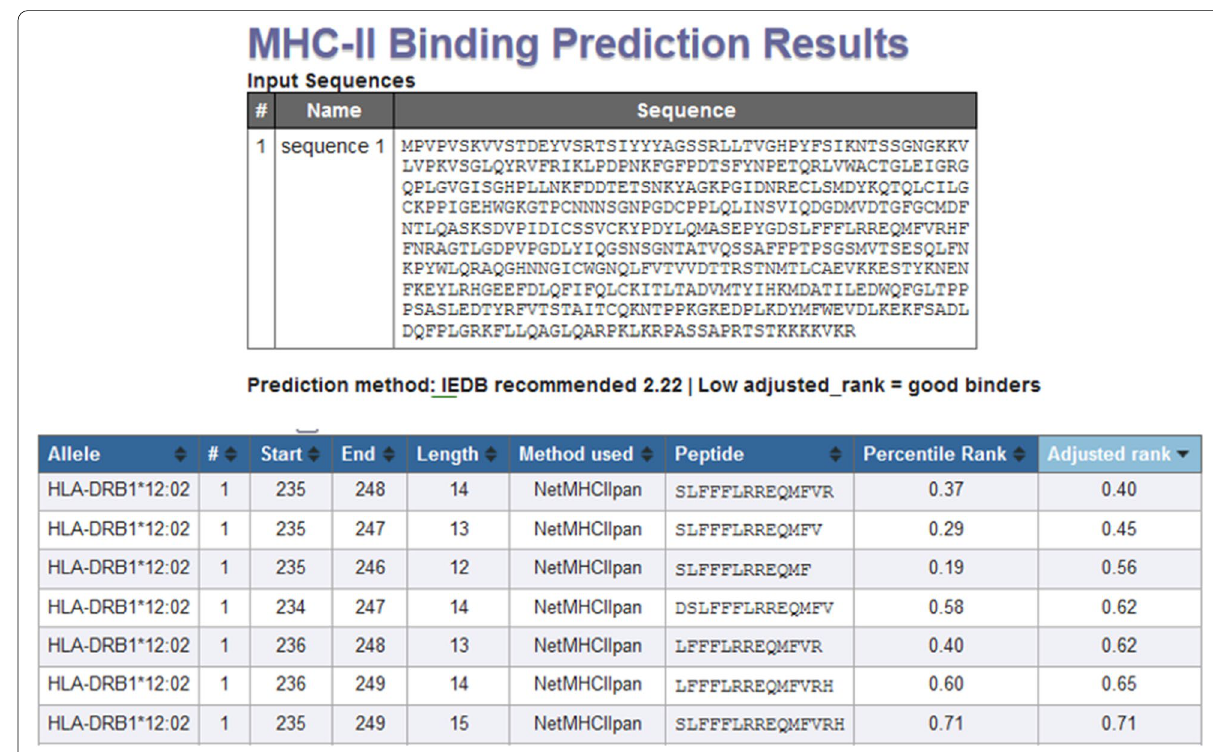
Fig. 14 Epitope T cell Prediction with Indonesian HLA class